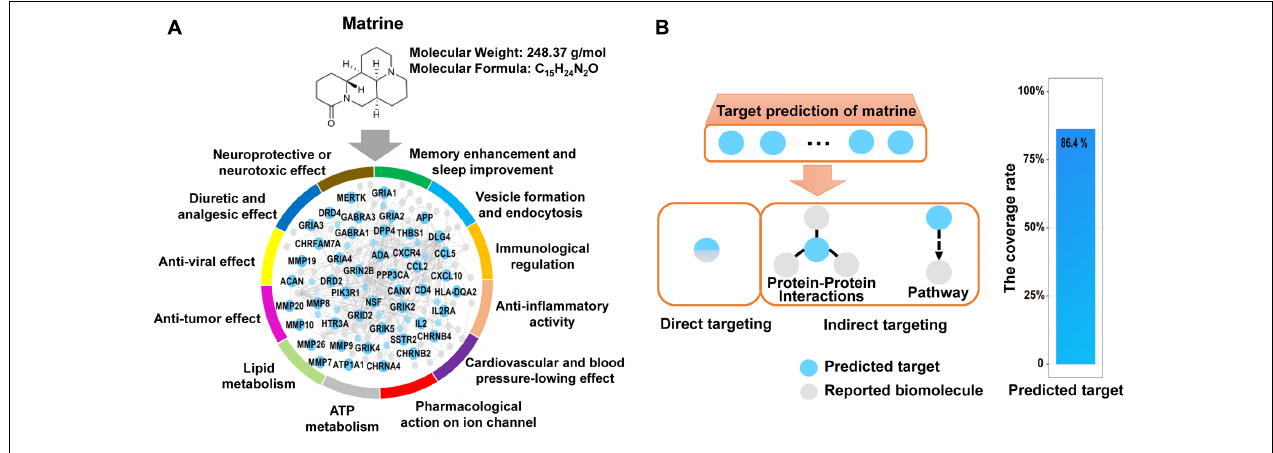
FIGURE 1 | Target prediction results of matrine and extensive literature verification. (A) Matrine-targeting molecular network with annotation labels comprising GO BP classes. (B) The coverage rate of the predicted targets of matrine toward reported biomolecules, which was calculated by [the intersection of the predicted targets and reported biomolecules/the number of reported biomolecules] × 100%. There are two main relationships between the predicted targets and reported biomolecules, direct and indirect association. Direct association represents that the predicted targets are identical with reported biomolecules. Indirect association represents that the predicted targets are linked to reported biomolecules by protein–protein interactions or